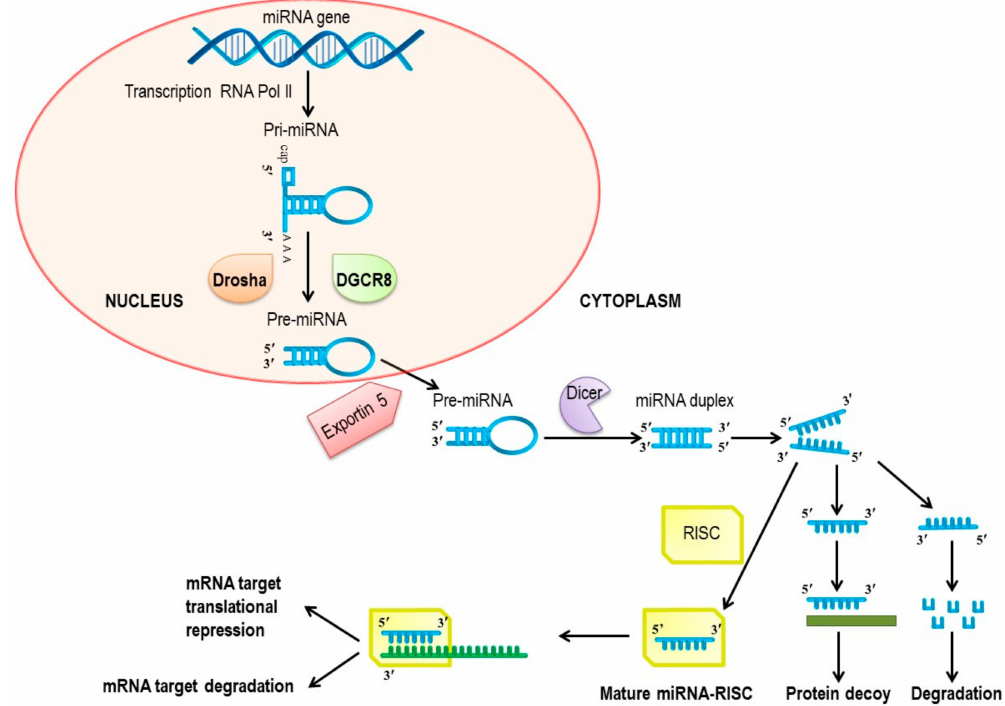
Figure 1. Biogenesis of miRNAs. miRNAs: microRNAs; mRNA: messenger RiboNucleic Acid; pri-miRNAs: primary miRNA transcripts; Drosha: Drosha ribonuclease III; Dicer: Dicer 1 ribonuclease III; DGCR8: DiGeorge syndrome critical region 8; pre-miRNA: precursor miRNA; RISC: RNA-induced silencing